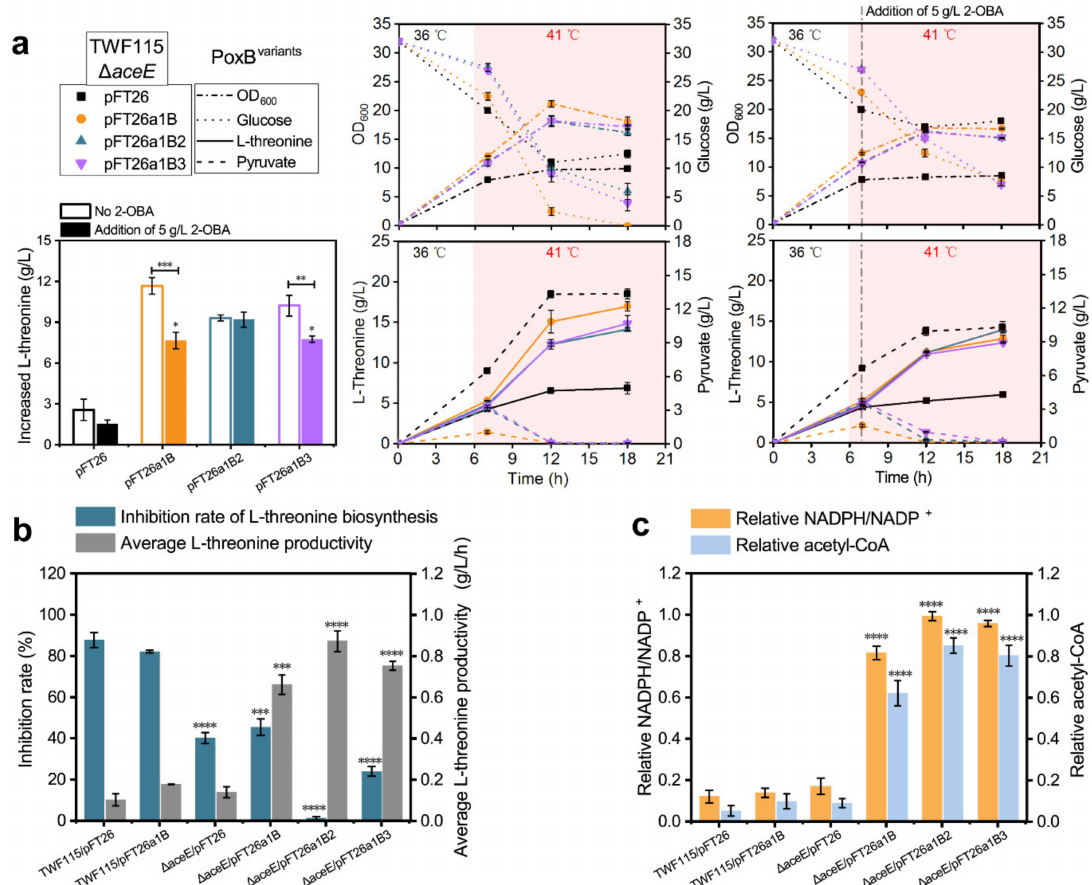
Figure 4. Detoxification of 2-OBA to synthesize L -threonine in engineered strains. ( a ) The fermentation of host strain TWF115 ∆ aceE harboring the expression vectors of reconstructed acetate bypass with PoxB variants, PoxB F112W and PoxB F112W/L253F . The time-point of temperature shift from 36 ◦ C to 41 ◦ C was set as 6 h, and the time point of 2-OBA (5 g/L) addition was one hour after the temperature shift. The increased L -threonine after the addition of 5 g/L 2-OBA was recalculated by subtracting the L -threonine secreted 7 h before. Significance ( p -value) was evaluated by a two-sided t -test, compared to pFT26a1B2. ( b ) Inhibition rate of L -threonine biosynthesis and average L -threonine productivity under the toxic stress of 2-OBA. ( c ) Relative levels of intracellular NADPH/NADP + and acetyl-CoA in the presence of 5 g/L 2-OBA as compared to TWF115/pFT26 with no 2-OBA addition. ( b , c ) Significance ( p -value) was evaluated by a two-sided t -test, compared to TWF115/pFT26. The s.d. is shown as black error bars. The two-tailed Student’s t -test was used for statistical analysis (**** indicates p -value < 0.0001, *** indicates p -value < 0.001, ** indicates p -value < 0.01, * indicates p -value <